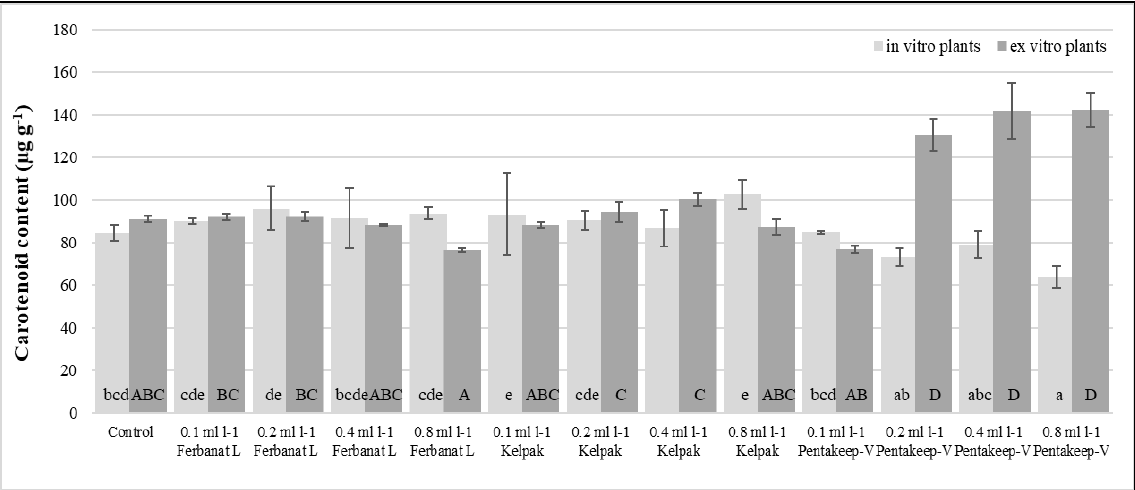
Figure 3. Carotenoid content of in vitro and ex vitro Hosta ’Gold Drop’ plants. Values are mean ± SD. Bars with different letter are significantly different by Tukey’s and Games-Howell’s comparison test at p≤0.05